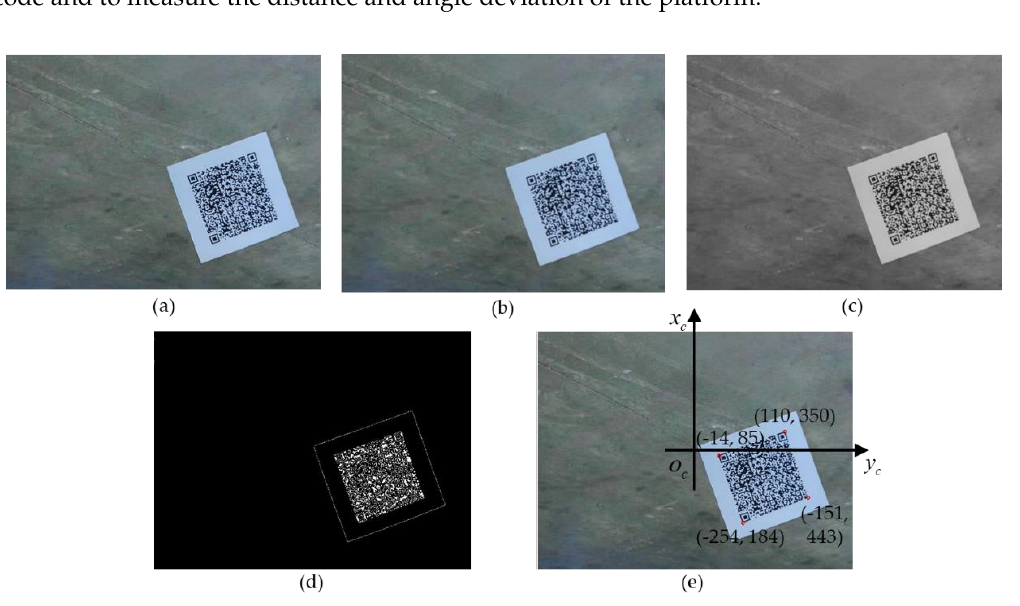
Figure 9. The processing resultant images: ( a ) original image; ( b ) after a Gauss filter; ( c ) converted to gray-scale; ( d ) after Canny edge detection; and ( e ) the original image with the image coordinate system and the coordinates of the four corners of the QR code.